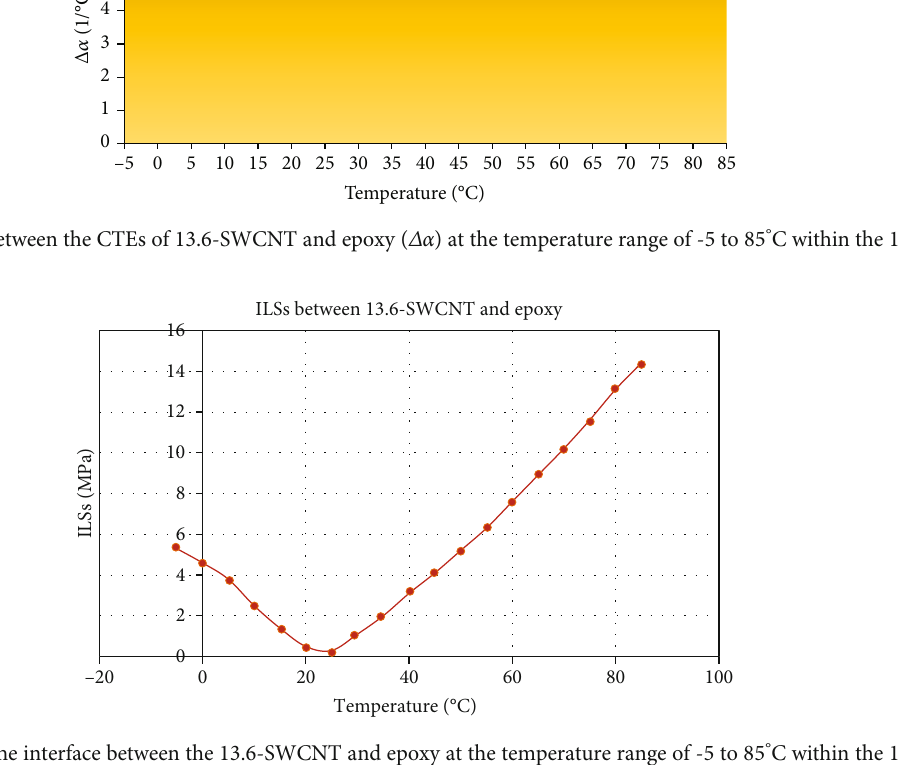
Figure 10: ILSs within the interface between the 13.6-SWCNT and epoxy at the temperature range of -5 to 85 ° C within the